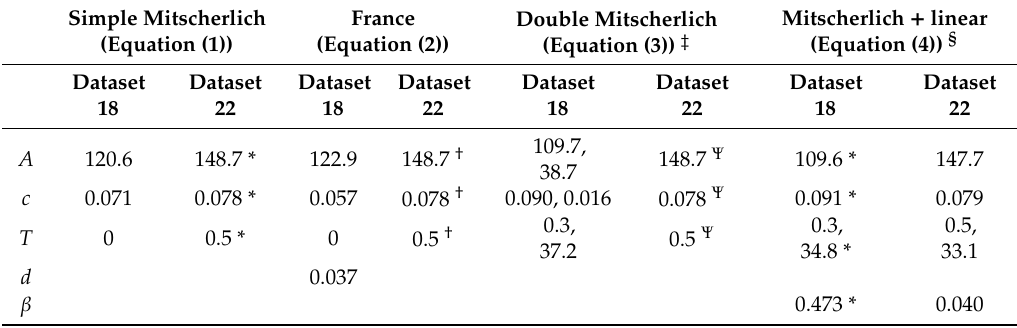
Table 3. Parameter estimates obtained by fitting Equations (1)–(4) to Dataset 18 (50% grass hay + 50% alfalfa) and 22 (50% grass hay + 50% concentrate), from Experiment 2. An asterisk (*) denotes the equation that resulted in the best fit, based on AIC, to a particular